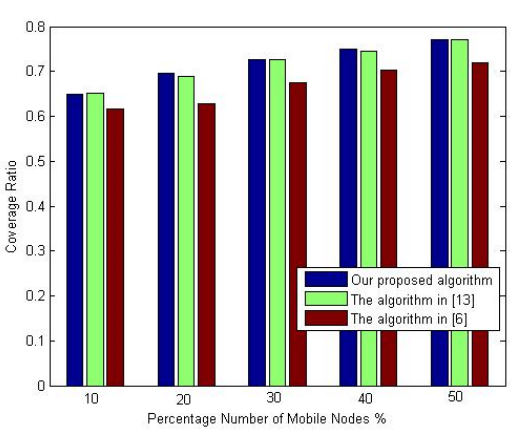
Figure 11. Influence of increasing percentage of mobile nodes on coverage ratio.